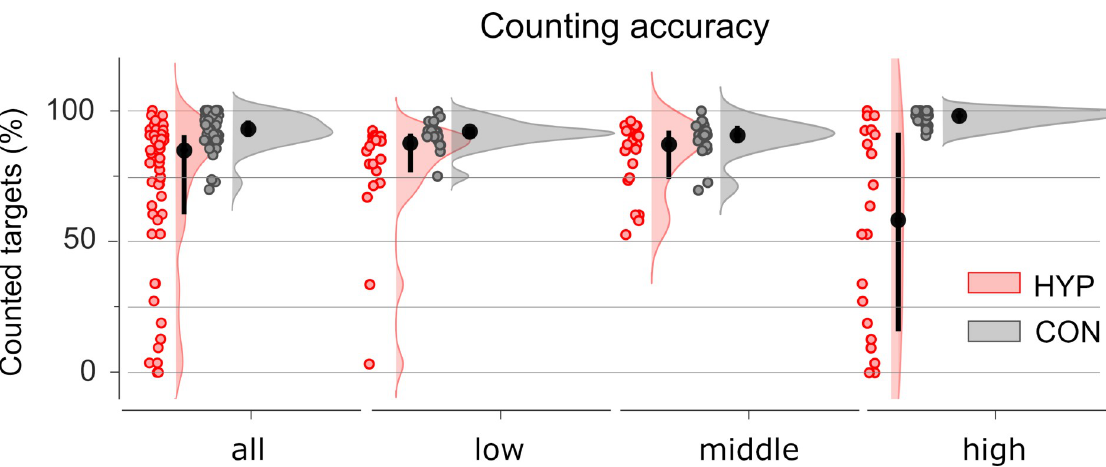
Fig 1. Counting accuracy in hypnosis (HYP, red) and control (CON, grey) depicted separately for the total group of participants (all) and the three subgroups of low, middle, and highly suggestible participants. Counting accuracy (%) was defined as the number of silently counted targets relative to the total number of targets presented. Black circles and lines mark the median and the interquartile range (difference between 75th and 25th percentiles), respectively. Pink and grey areas indicate the probability density function of the corresponding data